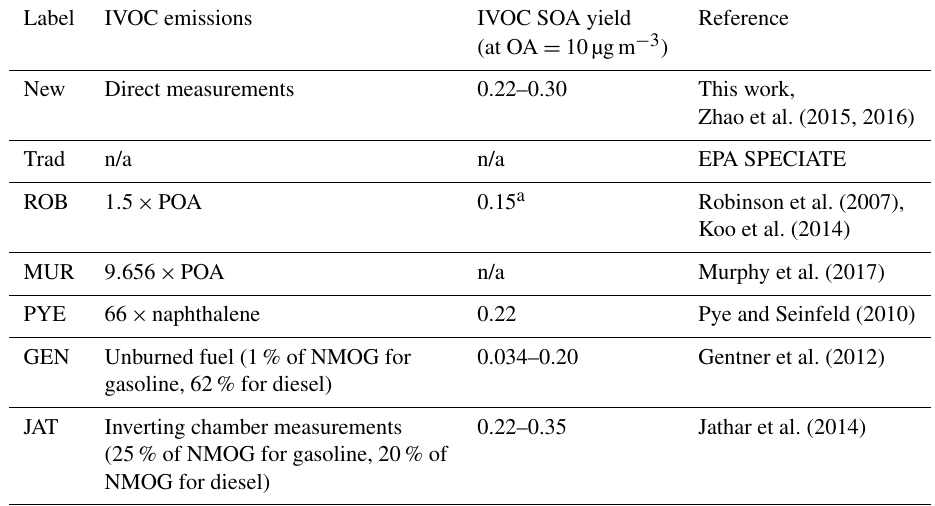
Table 1. List of different estimates of IVOC emissions and SOA yield for mobile sources shown in Fig. 7. Label